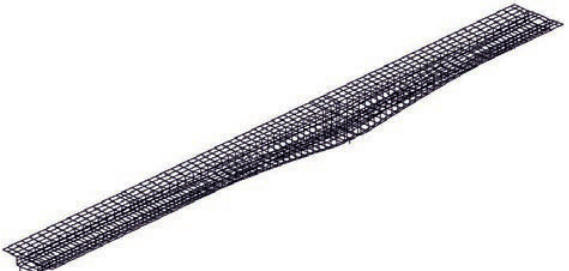
Fig. 10. The space-frame lattice model of half bridge